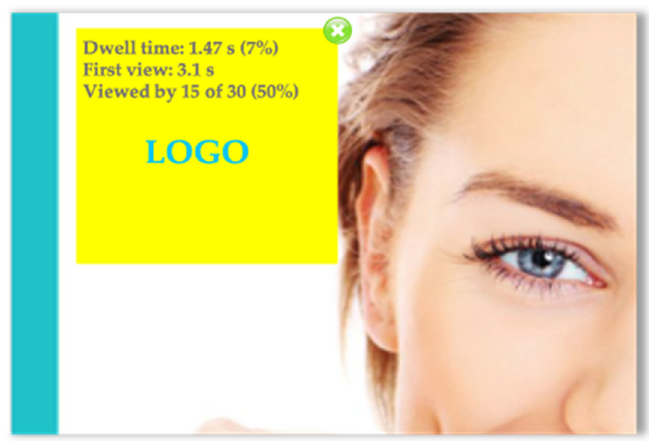
Figure 12. Heatmap analysis: Image B—area 2.